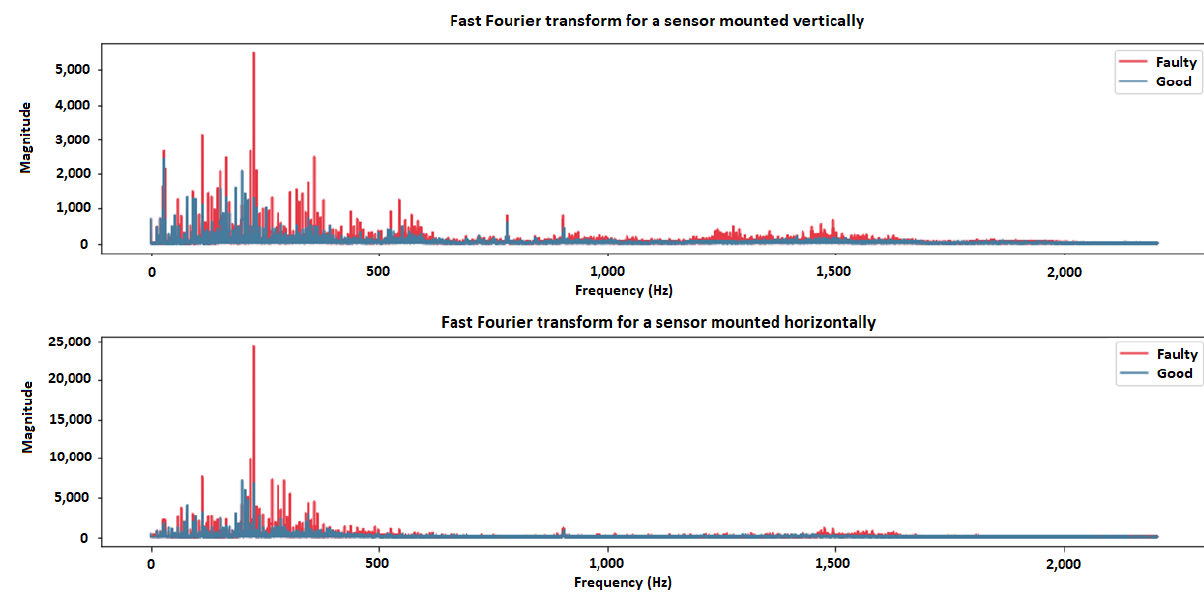
Figure 4. Fault belt drive analysis.